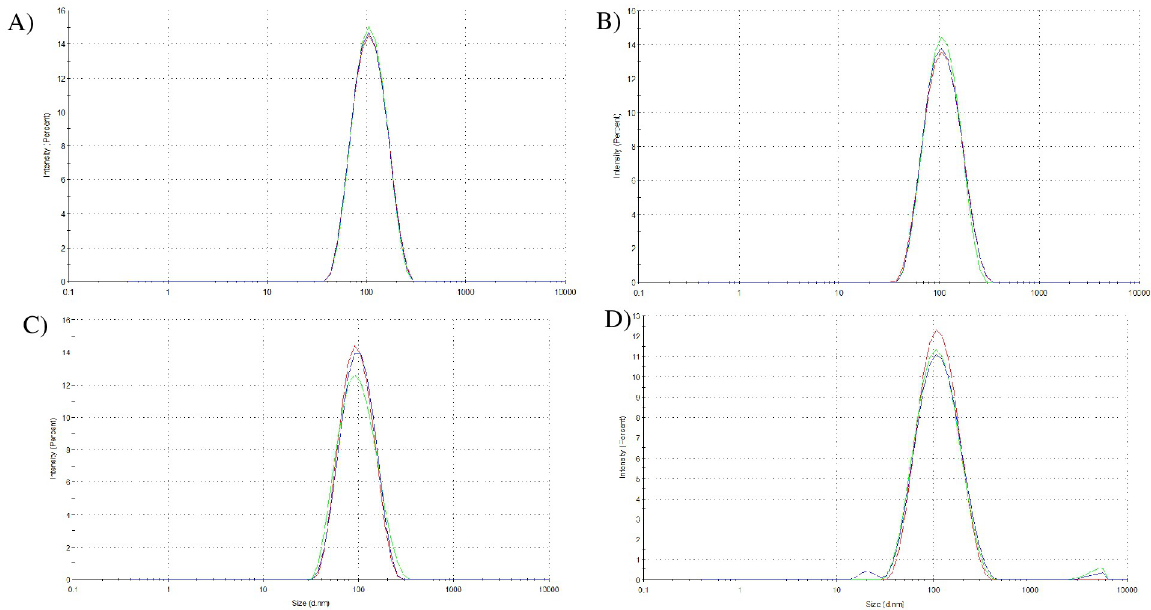
Fig 2. Particle size distribution of the A . triplinervis essential oils nano-emulsion A) morphotype A on day 0; B) morphotype B on day 0; C) morphotype A on day 21; and D) morphotype B on day 21. The X axis has the particle diameter (nm) and the Y axis has the peak intensity (%).